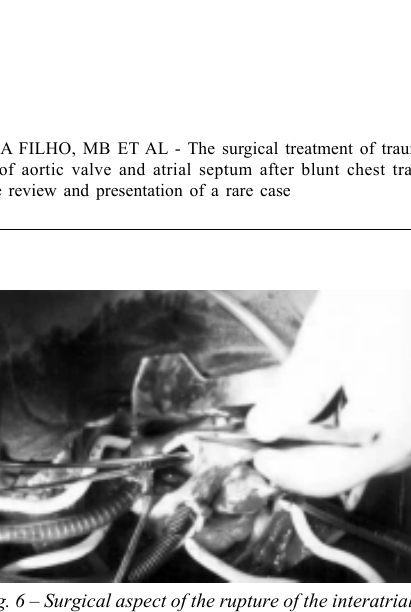
Fig. 6 – Surgical aspect of the rupture of the interatrial septum